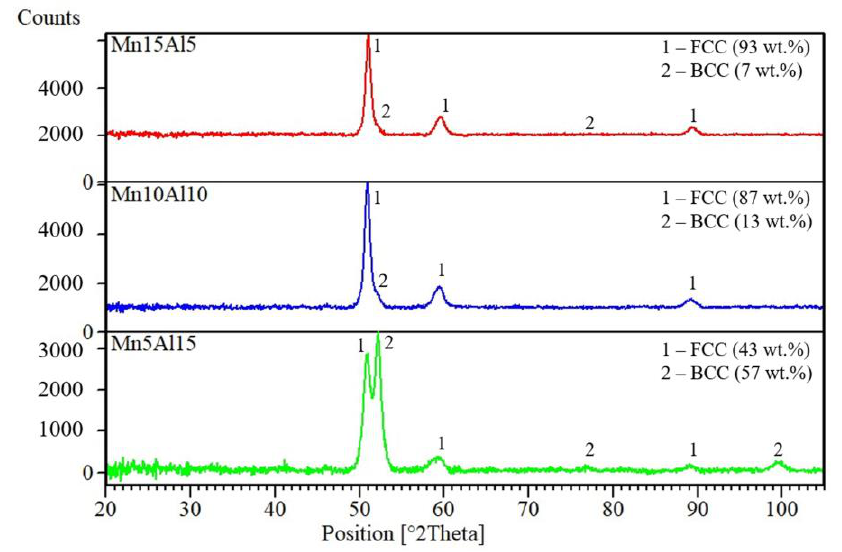
Figure 1. XRD patterns of the MA powder alloys corresponding to their chemical